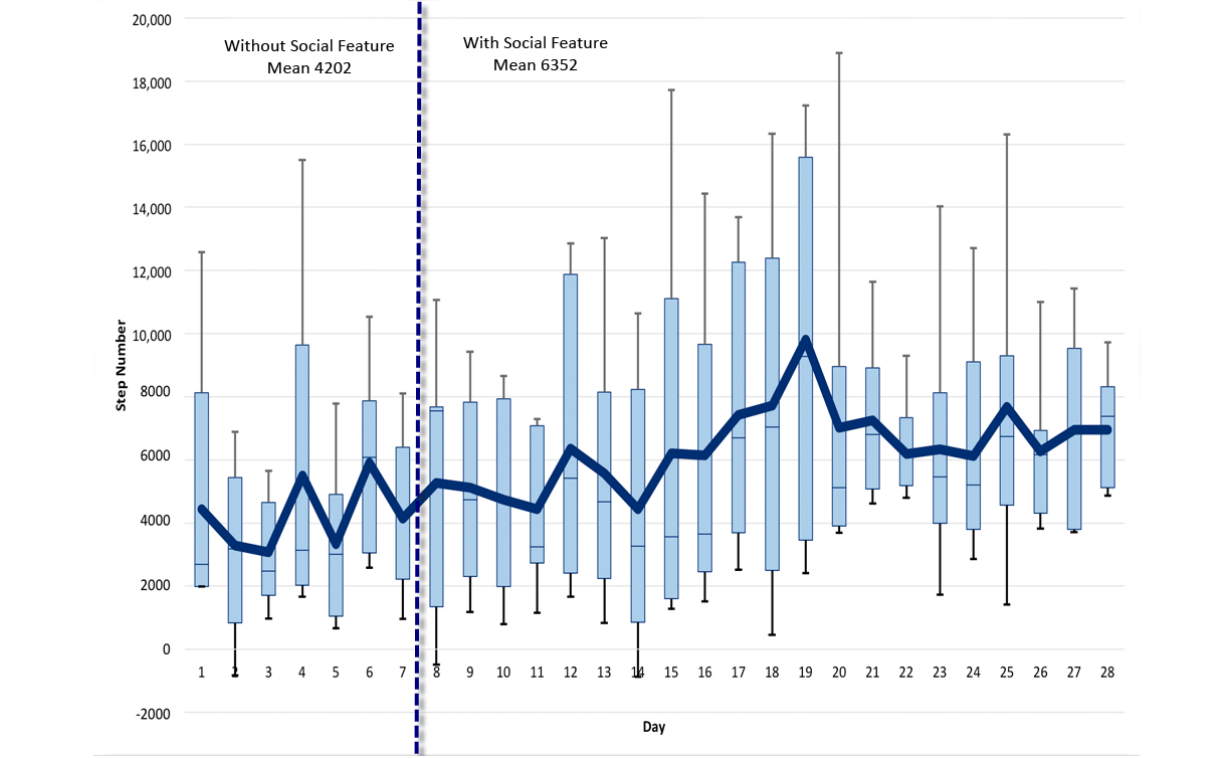
Figure 7. Steps comparison between baseline and social intervention.